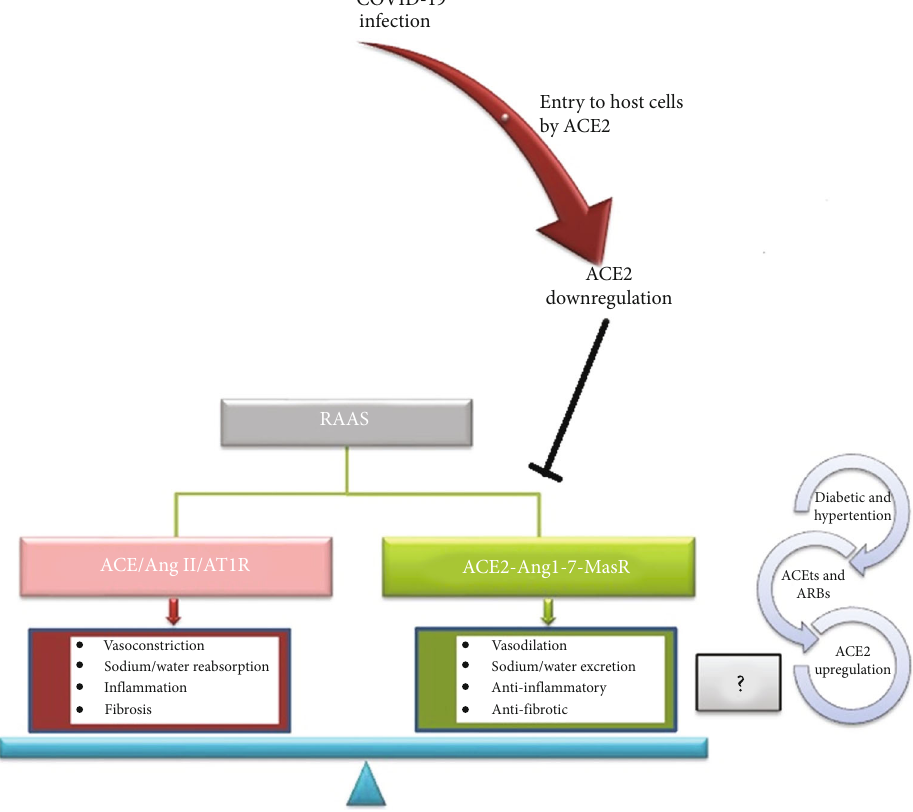
Figure 2: The function of two arms of renin-angiotensin-aldosterone system (RAAS) axis: the RAAS consists of two pathways including (i) ACE/Ang II/AT1R: in the pathway, Ang II which cleaved from Ang I by ACE activity, interacts with AT1R to induce vasoconstriction, in fl ammation, and fi brosis. (ii) ACE2-Ang1-7-MasR: in the pathway Ang 1-7 negatively regulate RAAS through promotion of vasodilation, anti-in fl ammatory and anti fi brotic e ff ects by interaction with MasR. Ang 1-7 are produced from cleavage of Ang II by ACE2 or metabolized of inactivated Ang 1-9 (cleaved from Ang I by ACE2) by ACE. The balance between two arms determines healthy state. In COVID-19 infection, ACE2, main receptor to SARS-CoV-2 entrance, is signi fi cantly decreased which results to inhibition of protective function of ACE2-Ang1-7-MasR arm. In opposite, the increased level of ACE2 resulted from ACEI and ARB medication in diabetic and hypertensive patients is considered as a double-edged sword which has been raised a big question: which aspects of increased ACE2 could be dominated during COVID-19 infection? increased susceptibility to viral infection or protective potential in RAAS